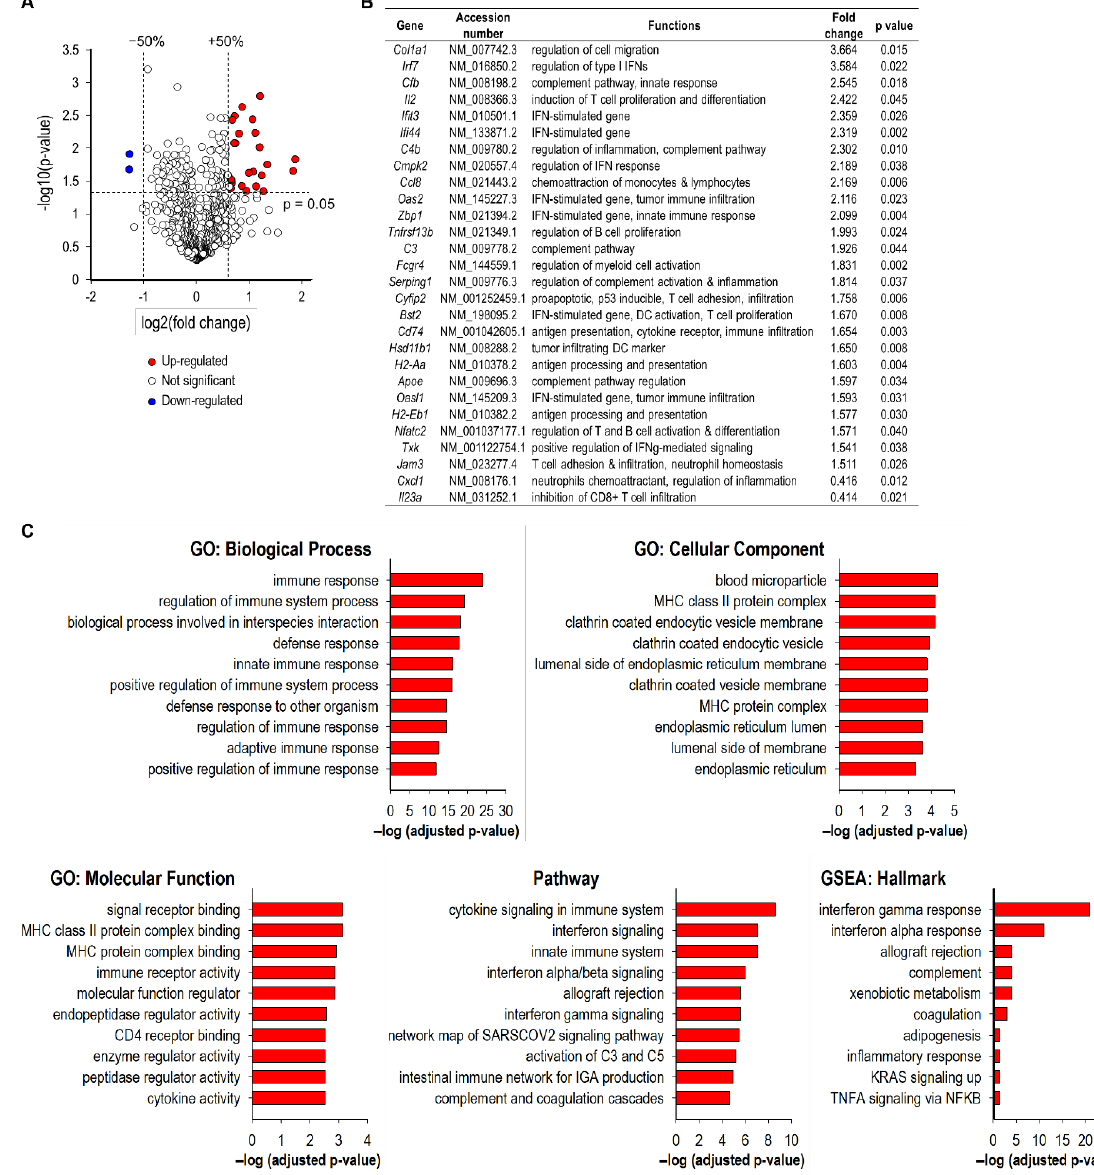
Figure 3. Transcriptomic analyses of tumors using NanoString Immune Profiling assay. ( A ) Volcano plot showing differential expression of immune related genes in anti-PD-1 plus SGT-53 versus the baseline of anti-PD-1 monotherapy. Volcano plot is presented as fold change in gene expression [log2(fold change)] against significance of change [ − log10( p -value)]. ( B ) The list of genes with a significant change. ( C ) GSEA analysis of 28 identified differentially expressed genes. Groups reflect main categories of GO terms: biological process; cellular component; molecular function, hallmark, and canonical pathway. Vertical and horizontal axes represent each category term and − log10(FDR adjusted p -value) of the corresponding term, respectively.